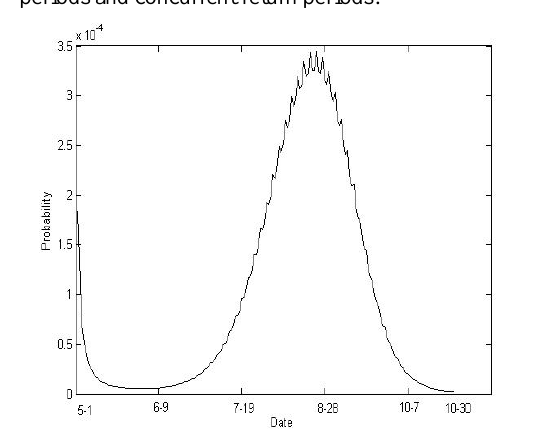
Fig. 7. Daily encounter risk between the AMFODs of